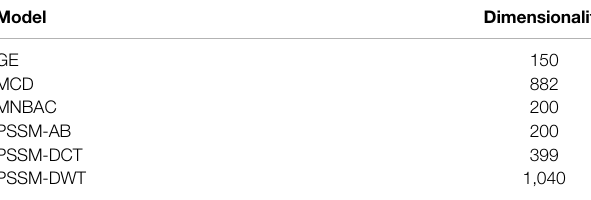
TABLE 1 | Dimensional information about the